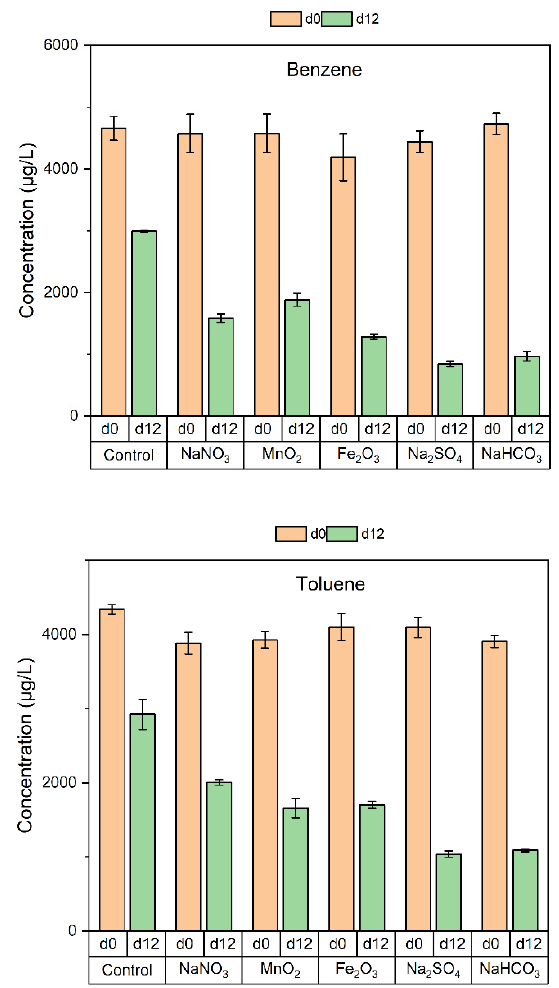
Table 4. Biodegradation rate constants of BTEX in the presence of various electron acceptors (/d).